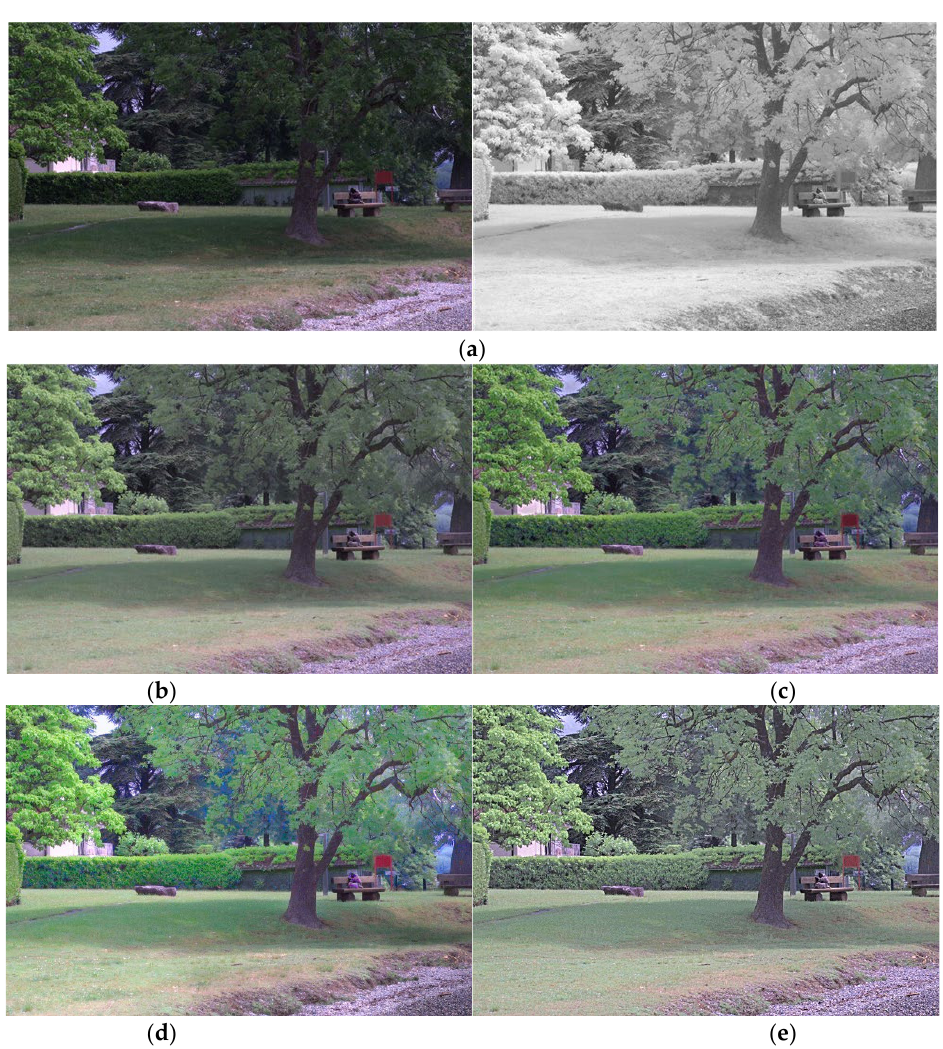
Figure 14. Daytime input and result images (2): ( a ) visible-light image and near-infrared image, ( b ) Densefuse method result, ( c ) Vanmali method result, ( d ) PCA method result, ( e ) proposed method result.